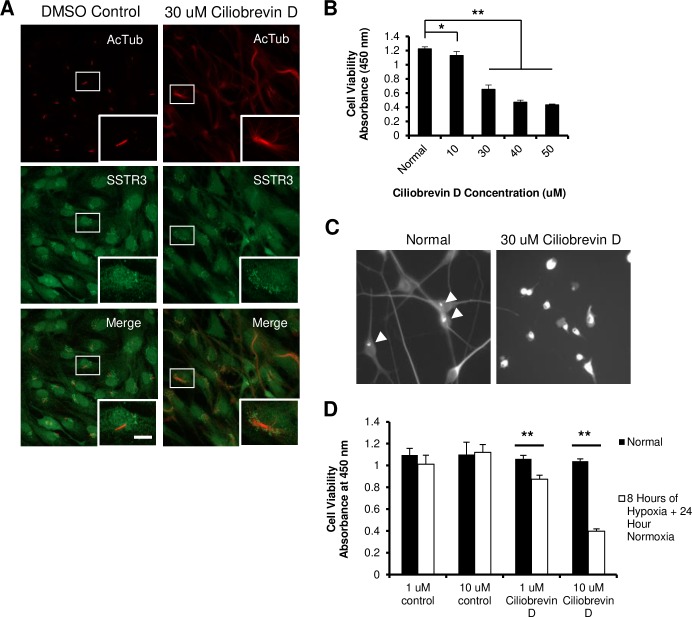
Disruption of IFT ablates cilia and sensitizes N1E-115 cells to hypoxia.(A) Dynein inhibition via 24 hours of Ciliobrevin D treatment disrupted the normal axoneme organization resulting in the loss of primary cilia in RPE1 cells and disarrayed tubulin organization (Right). Green = somatostatin 3 receptor, Red = Acetylated α tubulin. Scale bar = 10 μm. (B) N1E-115 Ciliobrevin D toxicity curve as measured by WST-8 assay (G) (**p<0.01, *p<0.05) showing increasing cell toxicity with higher concentrations. (C) Representative micrographs of immunofluorescence against AcTub in normal N1E-115 cells, to identify primary cilia (arrowhead), compared to a culture treated with 30 μM Ciliobrevin D (Right). Primary cilia were lost and neurites were also ablated. (D) Quantification of N1E-115 survival by WST-8 after hypoxia. Ciliobrevin D treatment increased sensitivity to sublethal hypoxia compared to DMSO control, which had no effect. **p<0.01, *p<0.05. Data presented as mean ± SEM.